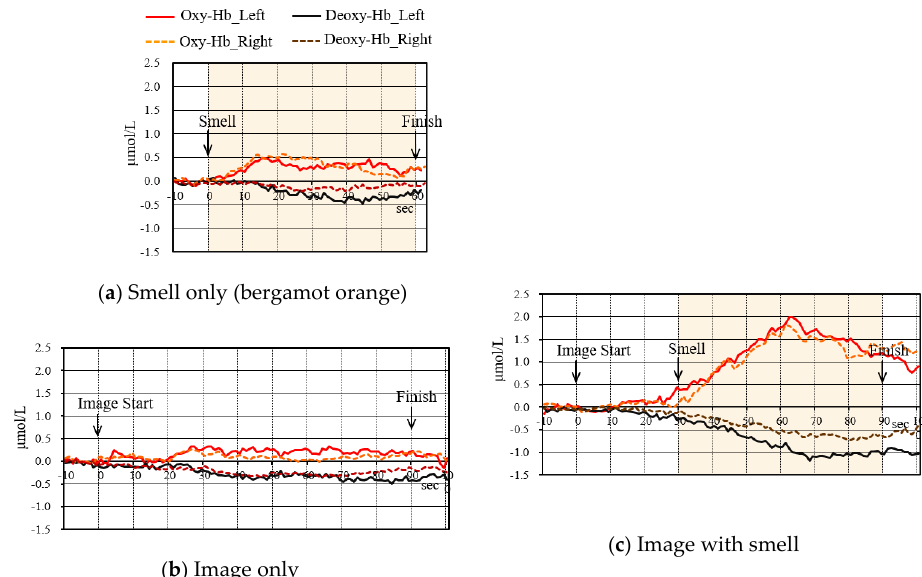
Figure11. NIRSresultsofthebergamotteastudy, clarifiedbyintegrating12subjects. (SolidLines / Dotted Figure 11. NIRS results of the bergamot tea study, clarified by integrating 12 subjects. (Solid Lines: Left / Right temple regions). (Red / Black: Oxy-Hb / Lines/Dotted Lines: Left/Right temple regions). (Red/Black: Oxy-Hb/Deoxy-Hb).